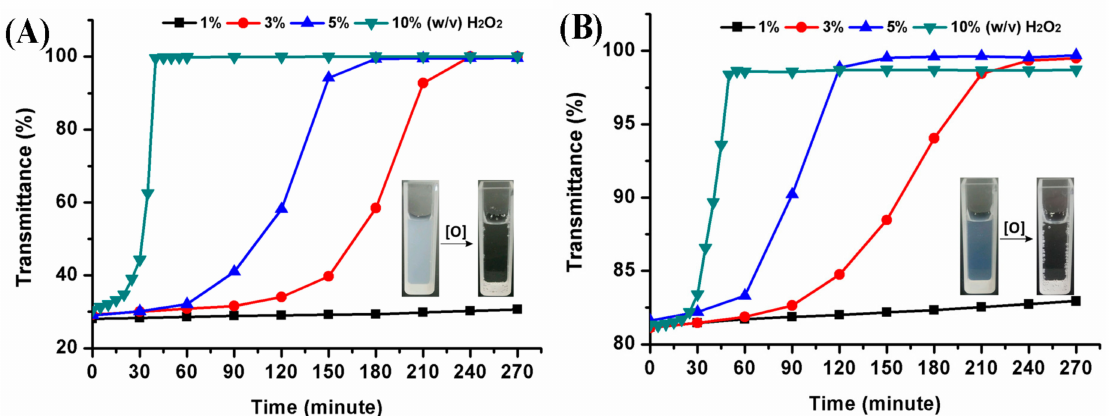
Figure 9. Turbidity measurements of hPTE-1 ( A ) and lPTE-1 ( B ) nanoparticles at di ff erent concentrations of H 2 O 2 at 25 ◦